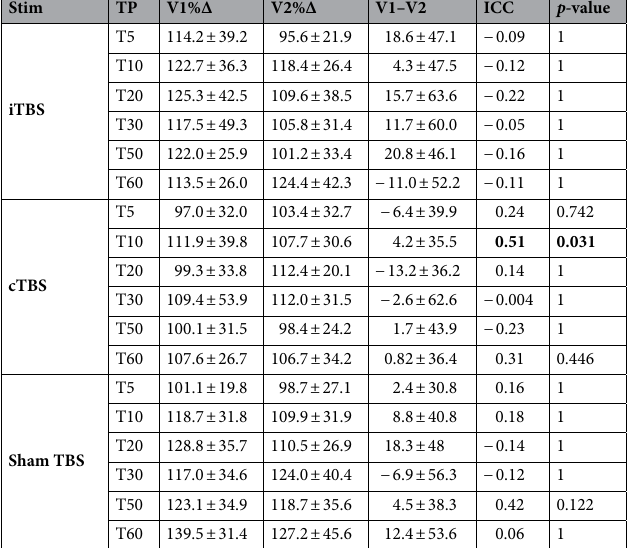
Table 1. MEP percentage change from baseline (mean + SD) and reliability of TBS protocols. Bonferroni- corrected p-values < 0.05 and associated ICCs are bolded. Stim TBS protocol, TP time point, V1/2%Δ